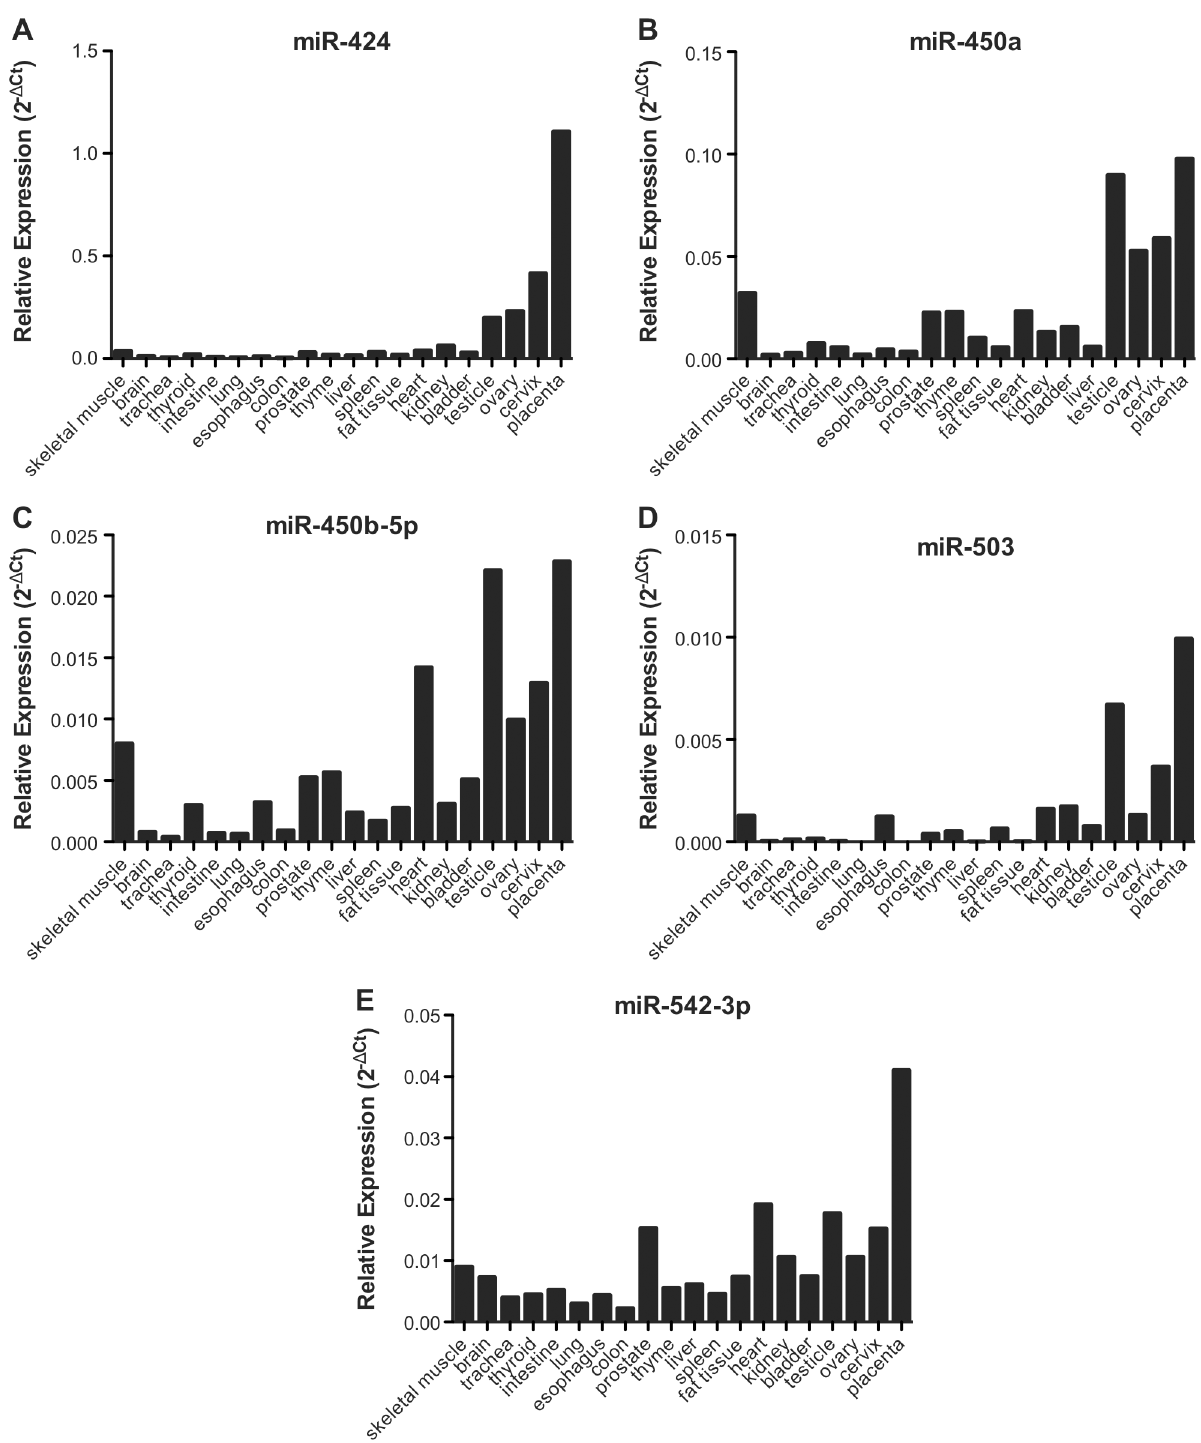
Fig 2. miRNAs flanking MIR503HG and LINC00629 genes are in general more expressed in reproductive tissues, a similar expression pattern as the lncRNAs. A-E: RT-qPCR analysis using RNA samples from a commercial normal human tissue panel and further normalized by geometric mean from the snoRNAs RNU24 and RNU48